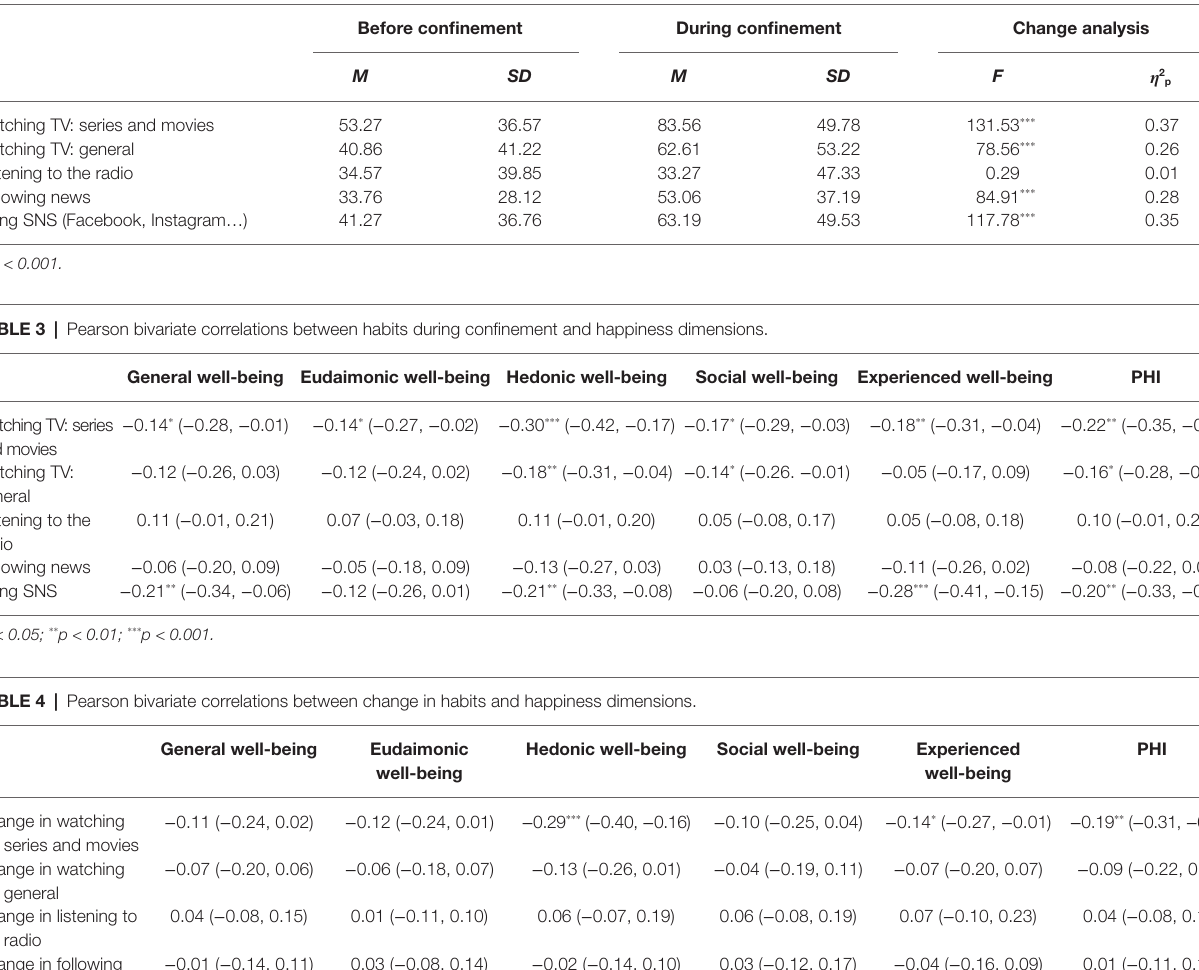
TABLE 2 | Descriptive statistics of habits before and during confinement, and analysis of the change. Before confinement During confinement Change analysis